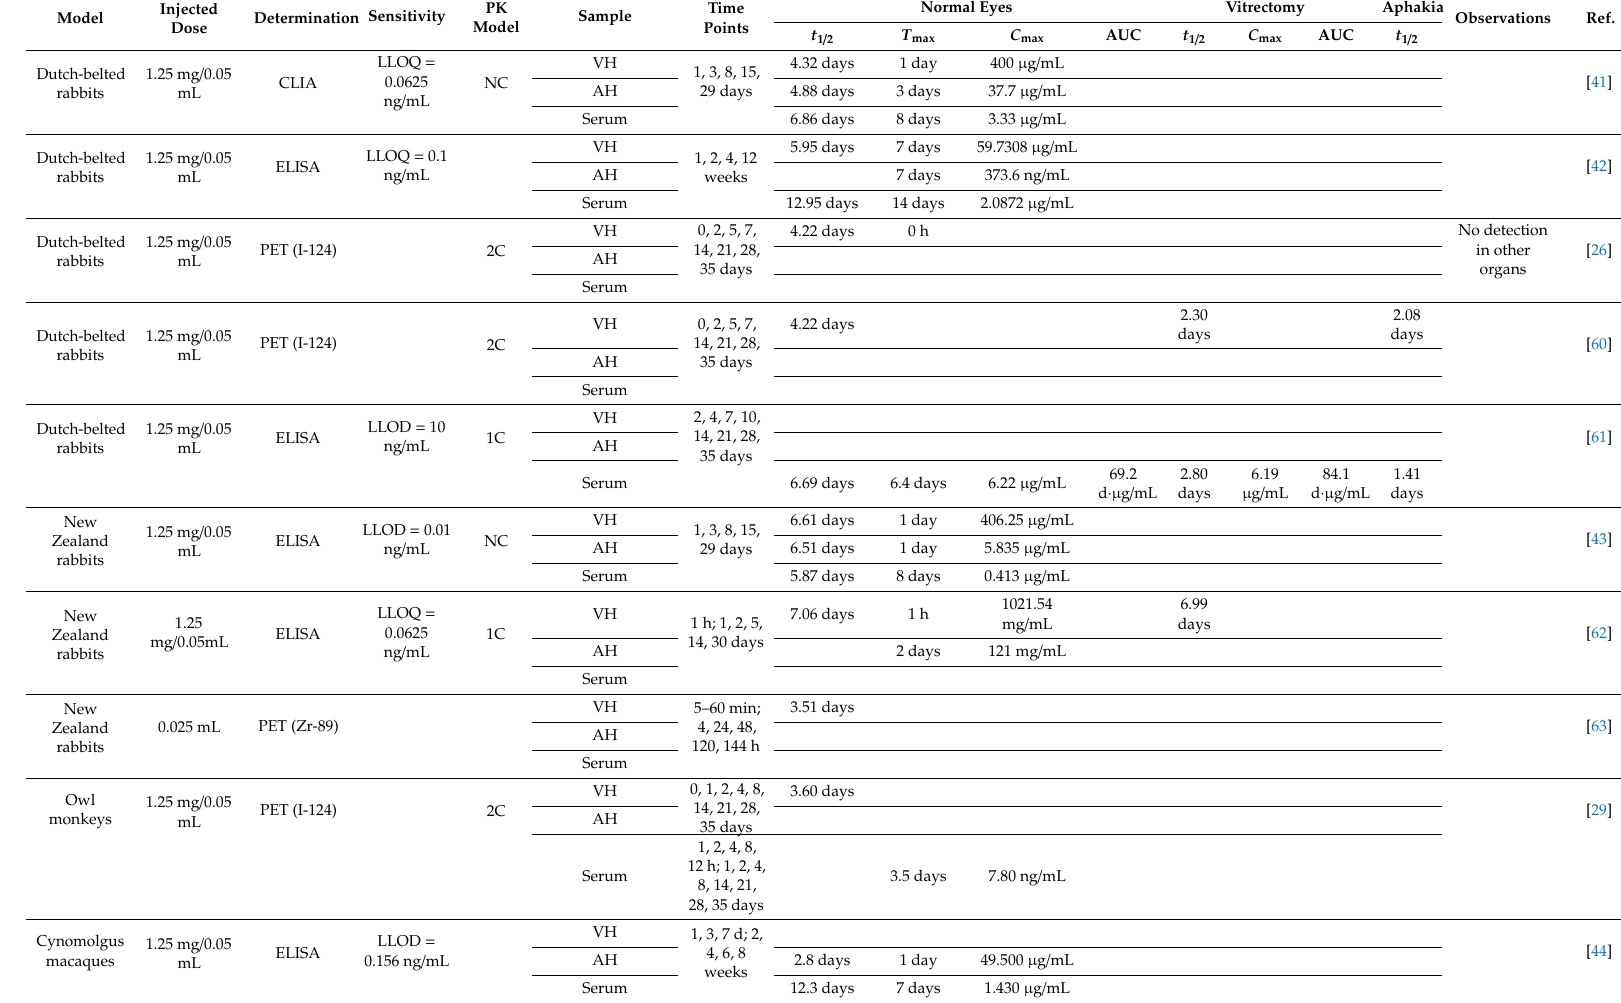
Table 3. Pharmacokinetic parameters of intravitreal bevacizumab in di ff erent